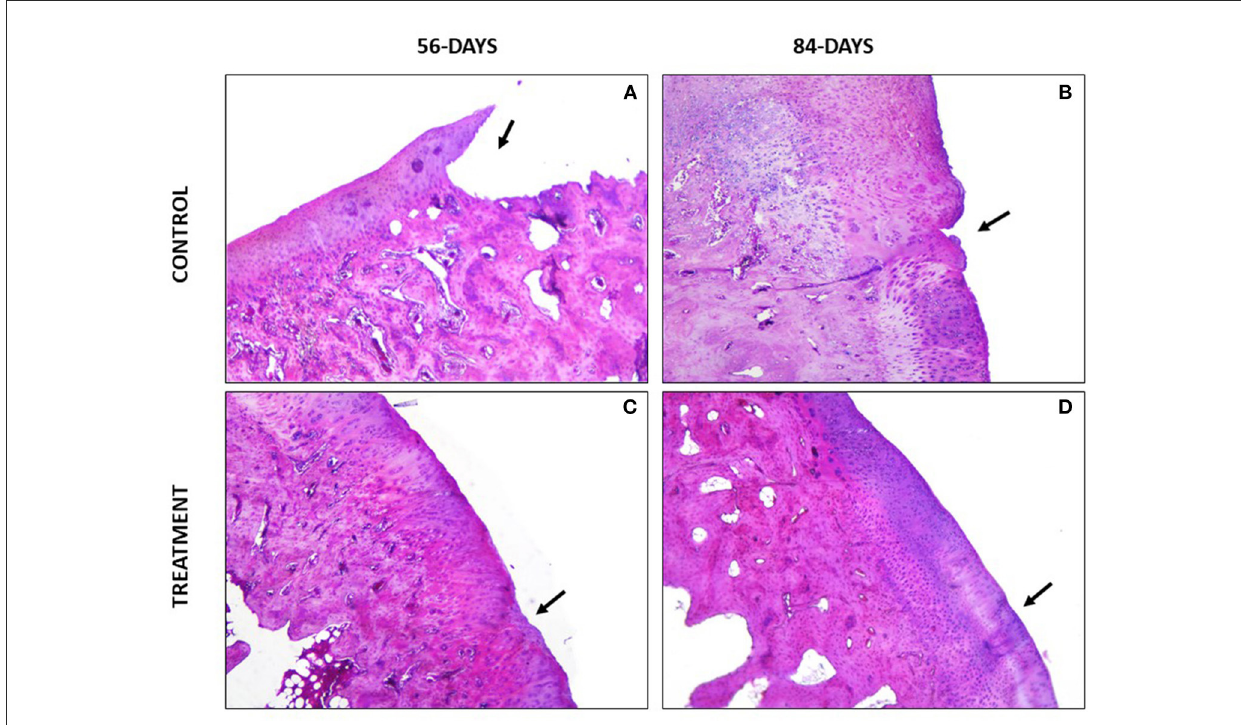
FIGURE5 Hematoxylin-Eosin stained sections. (A) Loss of superficial, mid and deep layers of the articular cartilage. (B) Clefts in the superficial zone and structural disorganization. (C) Small superficial erosion. (D) Good superficial integration with small irregularities.